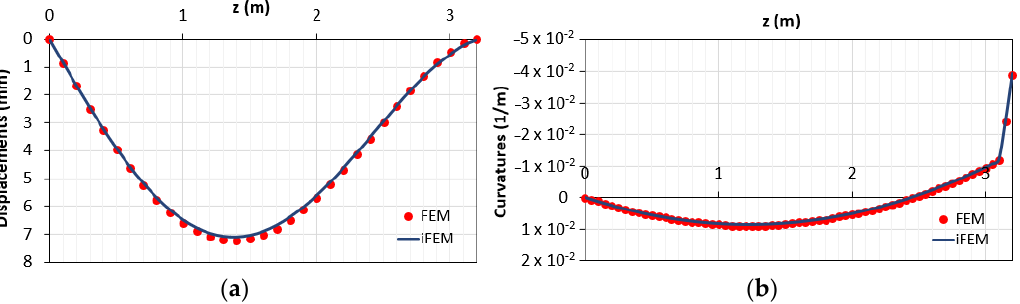
Figure 21. Results obtained with the proposed method: ( a ) displacements diagram; ( b ) curvatures diagram. The previous analysis provides the results with the percentage of differences reported in Figure 22.